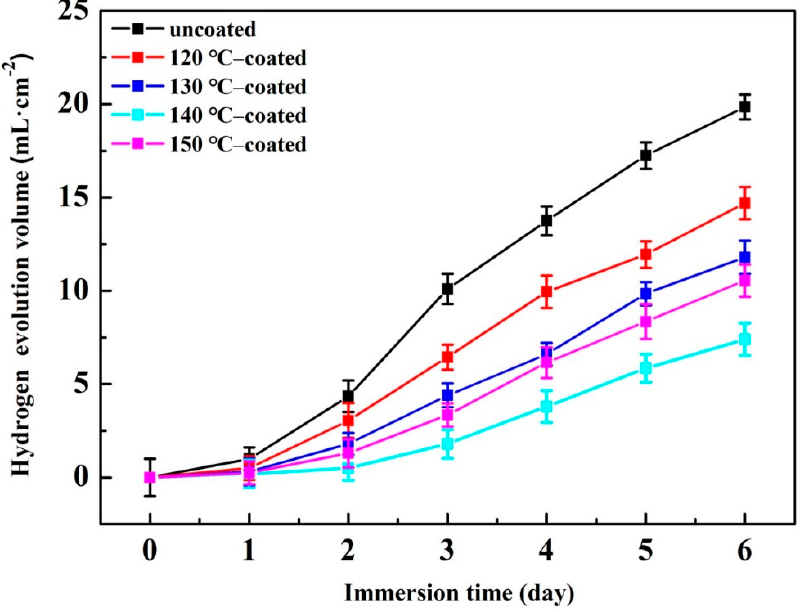
Figure 7. Hydrogen-evolution rates of the substrate and coated samples in NaCl